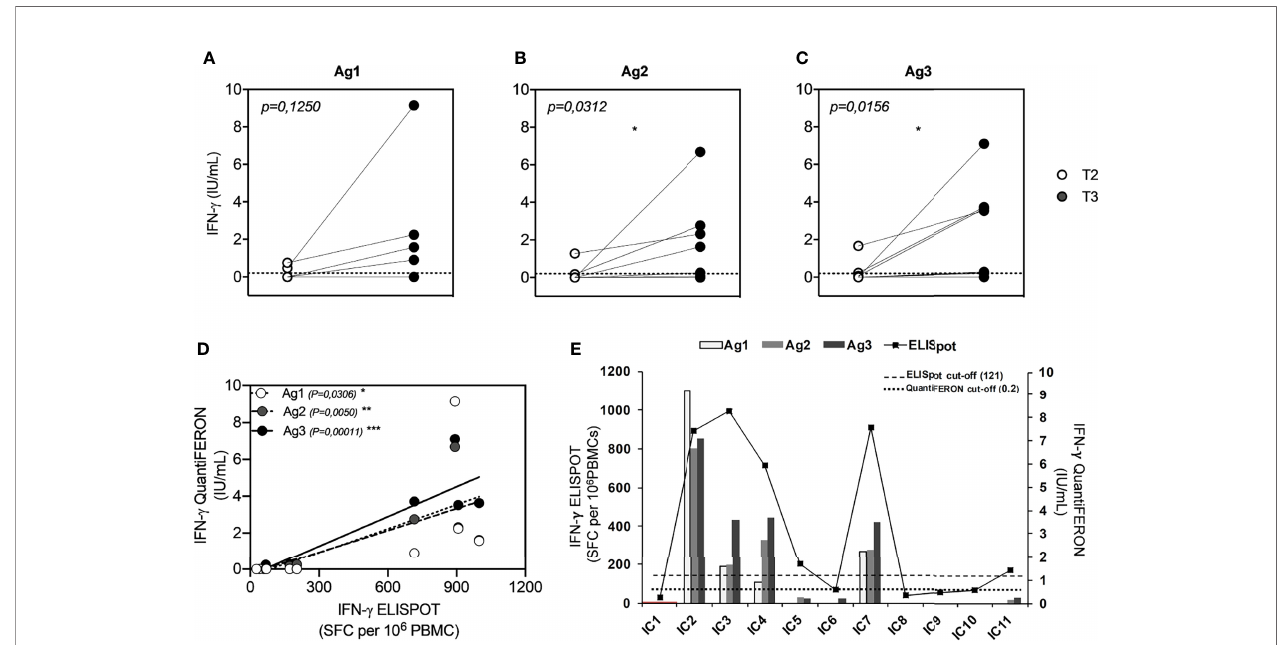
FIGURE 3 | Comparison of QuantiFERON SARS-CoV-2 antigen tube (Ag minus Nil) response, express as IFN- g (IU/ml), in seronegative subjects (ICs n=11) before (T2) and after (T3) the booster dose of the P fi zer-BioNTech BNT162b2 mRNA-based vaccine. (A) QFN-SARS-CoV-2 Ag1-Nil responses; (B) Ag2-Nil responses; (C) Ag3-Nil responses. The dotted lines, in each graph, correspond to IFN- g cutoff (0.2 IU/ml). (D) Correlation between IFN- g -ELISpot and IFN- g -QFN responses of each speci fi c antigen (Ag1 contains CD4+ epitopes derived from the S1 subunit of the spike protein; Ag2 contains CD4+ and CD8+ epitopes from the S1 and S2 subunits of the spike protein; and Ag3 contains CD4+ and CD8+ epitopes from S1 and S2, plus immunodominant CD8+ epitopes derived from the whole genome). (E) Graphic comparison of IFN- g -ELISpot and IFN- g -QFN responses of all subjects studied. The signi fi cance was determined using Wilcoxon matched-pairs test, *p = 0.0332 (A – C) and Pearson correlation, *p=0.0332; **p=0.0021;